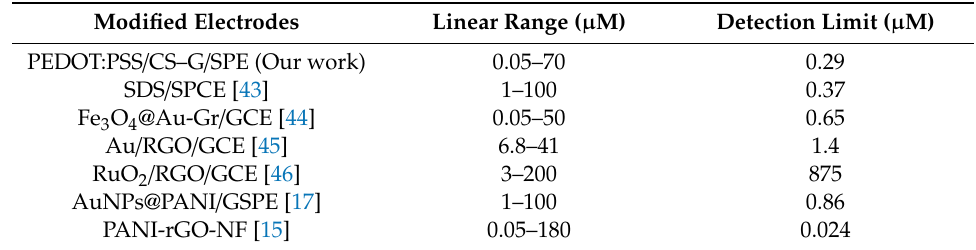
Table 1. Comparison of our PEDOT:PSS / CS–G / SPE using a self-designed detection system with other modified electrodes using various methods reported in the literature for the determination of